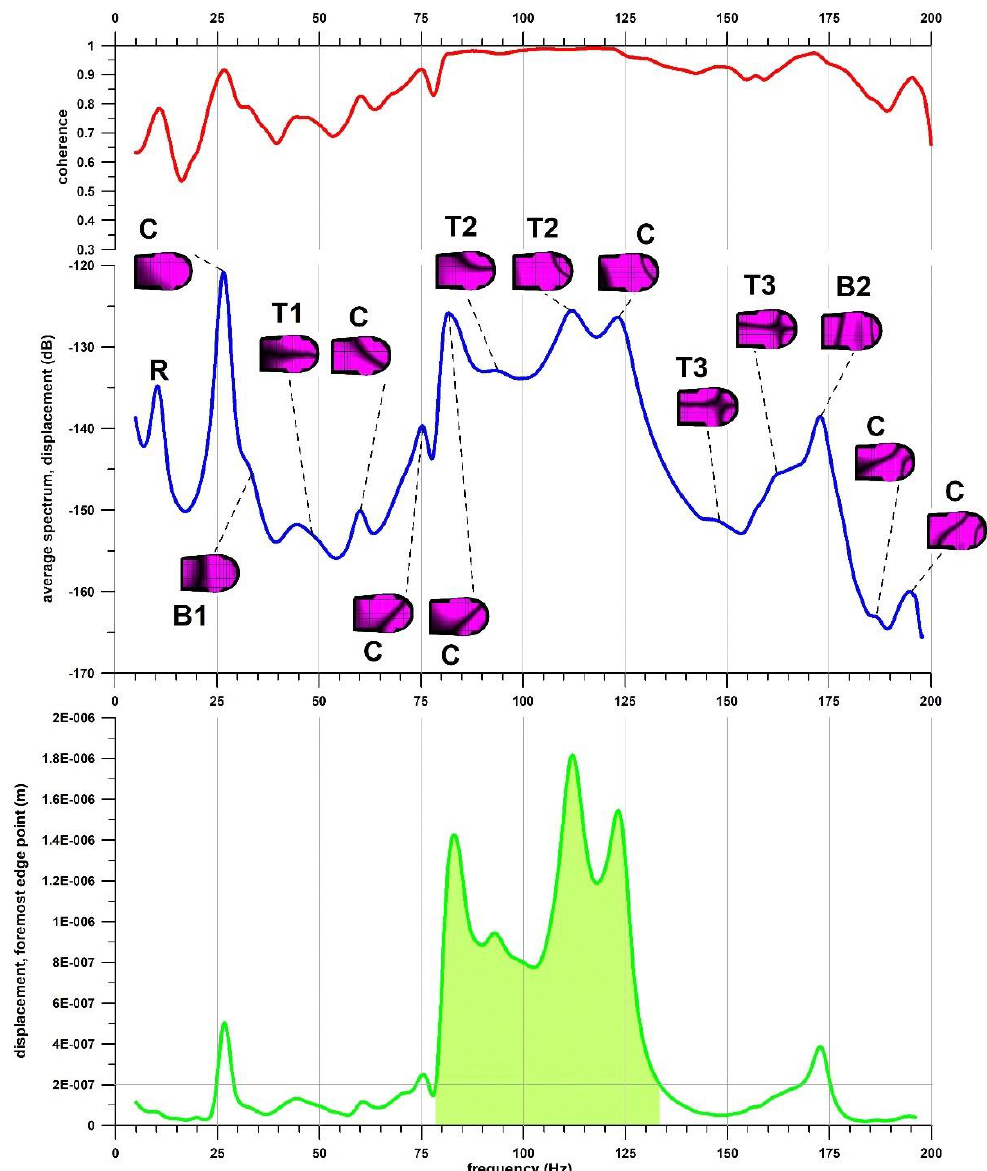
Figure 8. Board B tilted by 50°; coherence (red), average spectrum of the shovel’s displacement (blue; in dB), and displacement of the frontmost edge point (green; in m) against the frequency; the purple insets show the node lines of each mode; R = rigid body motion of the board plus test rig about the edge line; T = torsional mode, B = bending mode, C = combined (torsional and bending) mode; 1, 2, 3 = first, second, and third mode; the green area under the edge point displacement curve is used for calculating the edge mobility measure (magnitude of the displacement continuously exceeding 0.2 mm).